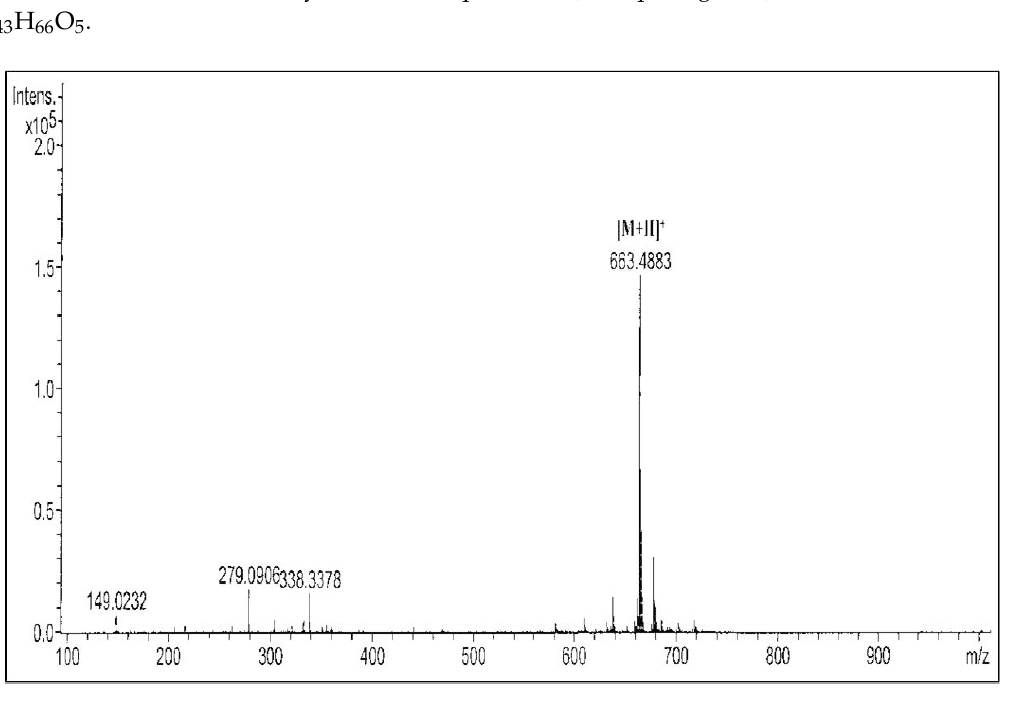
Figure 1. Mass spectrum of demethylbelamcandaquinone B.